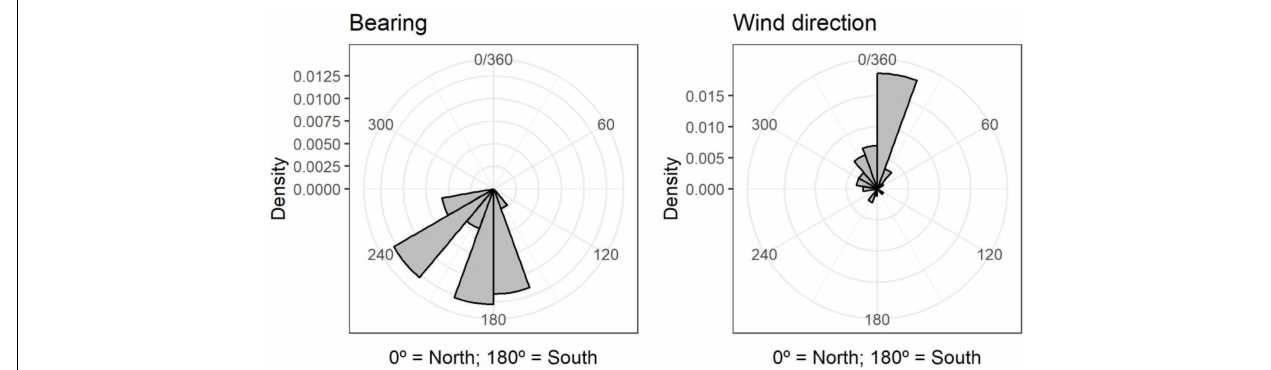
FIGURE 4 | Flight direction (bearing) and wind direction at the time of flight initiation.